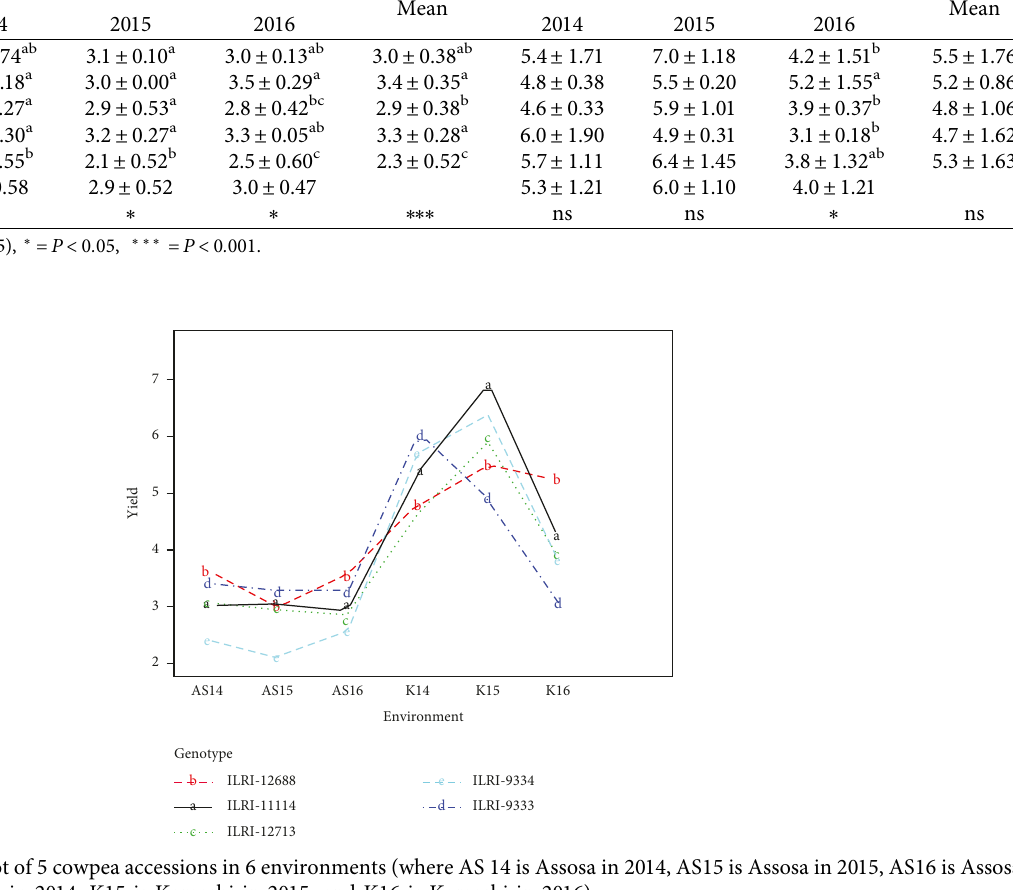
Table 4: Dry biomass yield (ton/ha) of cowpea genotypes under Assosa and Kamashi environments from 2014 to 2016 (mean ± SD). Genotype